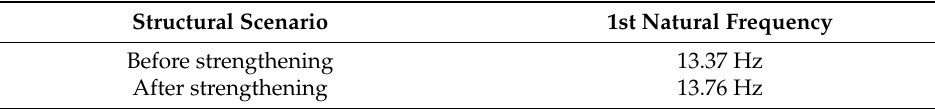
Table 5. SAE and SVM parameters of the proposed strategy for the Várzea Nova viaduct.